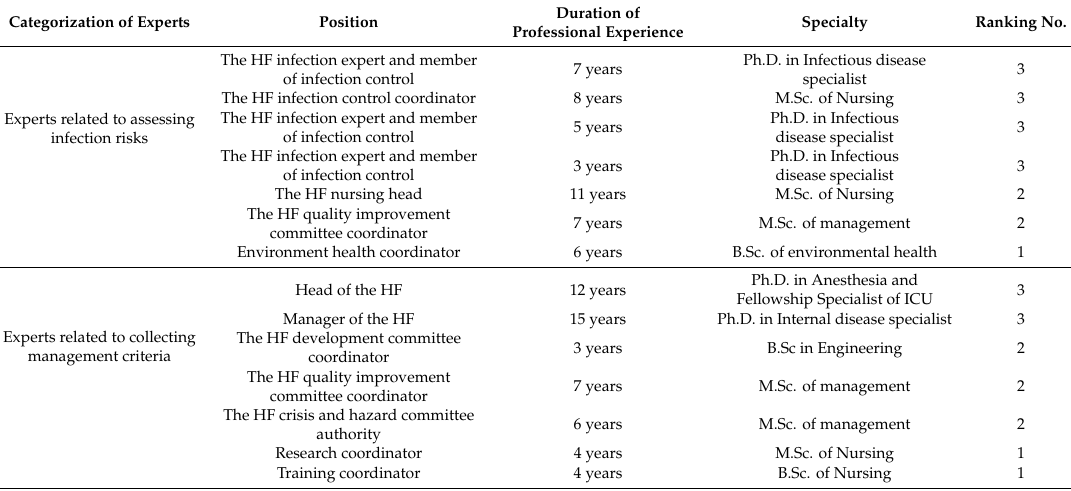
Table 1. List of experts and their ranking based on an unbalanced expertise method.